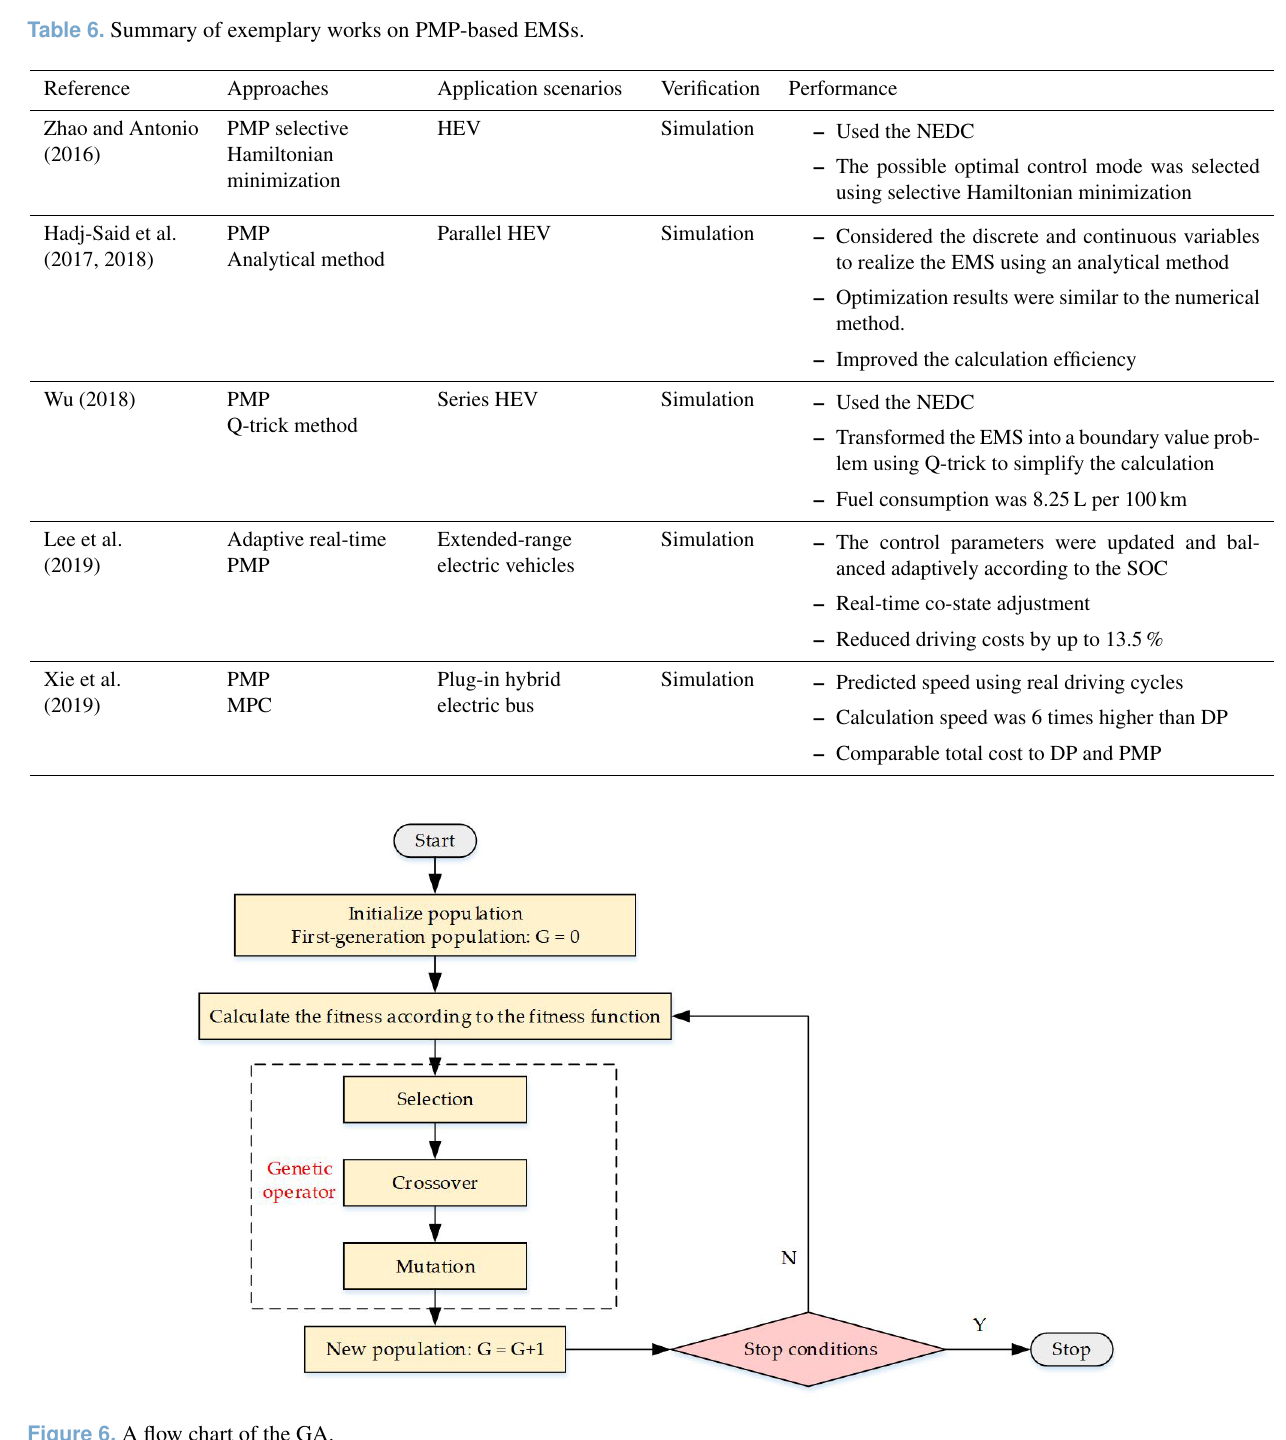
Figure 6. A flow chart of the